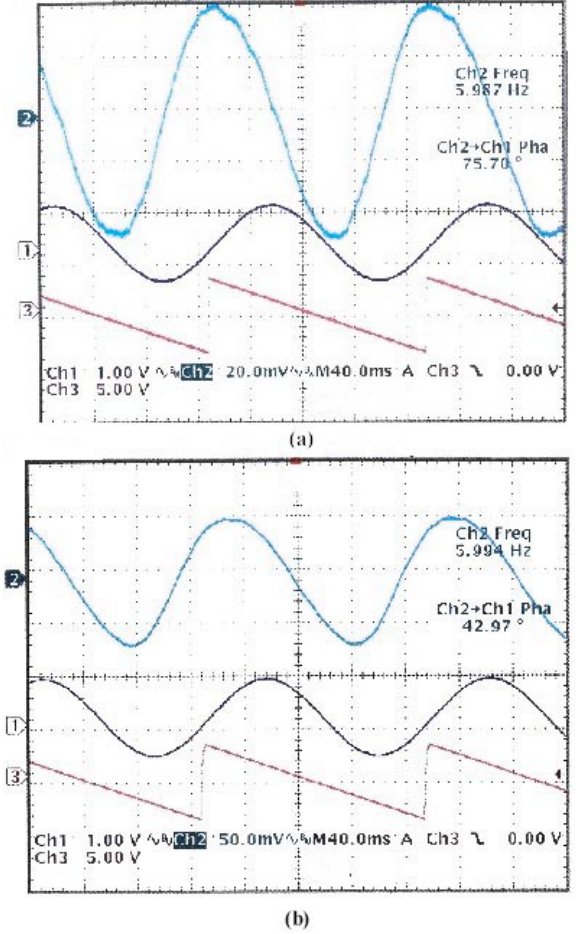
FIG. 8. (Color) Examples of resonator’s resultant field modu- lation, (a) R 111 tune, monitor at R 112 position; (b) R 114 tune, monitor at R 116 position. Top traces: amplitude feedback loop error signal; middle traces: modulation reference signal; bot- tom traces: sawtooth control voltage. Time scale is 40 ms = div